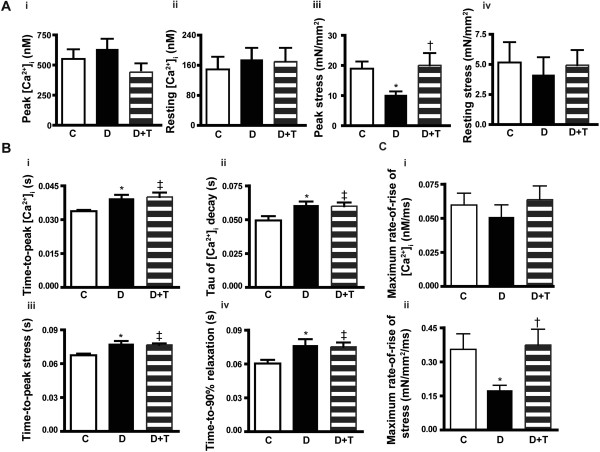
Depressed cardiac contractility in diabetic rats prevented by TETA-treatment. Depressed cardiac contractility in diabetic rats was prevented by TETA-treatment, which by contrast did not modify diabetes-induced alterations in [Ca2+]i homeostasis. (A) Diabetic rats showed unchanged peak (i) and resting (ii) [Ca2+]i values but had concomitantly decreased peak stress (iii) (Diabetic: 10 ± 1 mN/mm2; Control: 17 ± 2 mN/mm2, P = 0.02) and unchanged resting stress (iv). TETA-treatment preserved peak stress in diabetic rats (TETA-treated diabetic: 20 ± 4 mN/mm2, P = 0.04) but did not significantly modify peak or resting [Ca2+]i. (B) The time course of the Ca2+ transient was prolonged in diabetic rats: (time-to-peak [Ca2+]i (i); and time constant of decay of the Ca2+ transient (ii)), as was the time course of isometric stress (time-to-peak stress (iii); and time-to-90% relaxation (iv)). However, TETA-treatment had no effect on the time course of either variable. (C) The maximum rate of rise in the Ca2+ transient was unchanged (i) whereas the maximum rate of stress development was decreased in diabetic rats (ii), and this decrease was prevented by TETA-treatment. C: Control (Open bars, n = 10); D: Diabetic (Solid bars, n = 8); D + T: TETA-treated diabetic (Patterned bars, n = 7). Data are means ± SEM, one-way ANOVA with application of the post-hoc Holm-Sidak test: * C vs D; ‡ C vs D + T; † D vs D + T; P < 0.05.